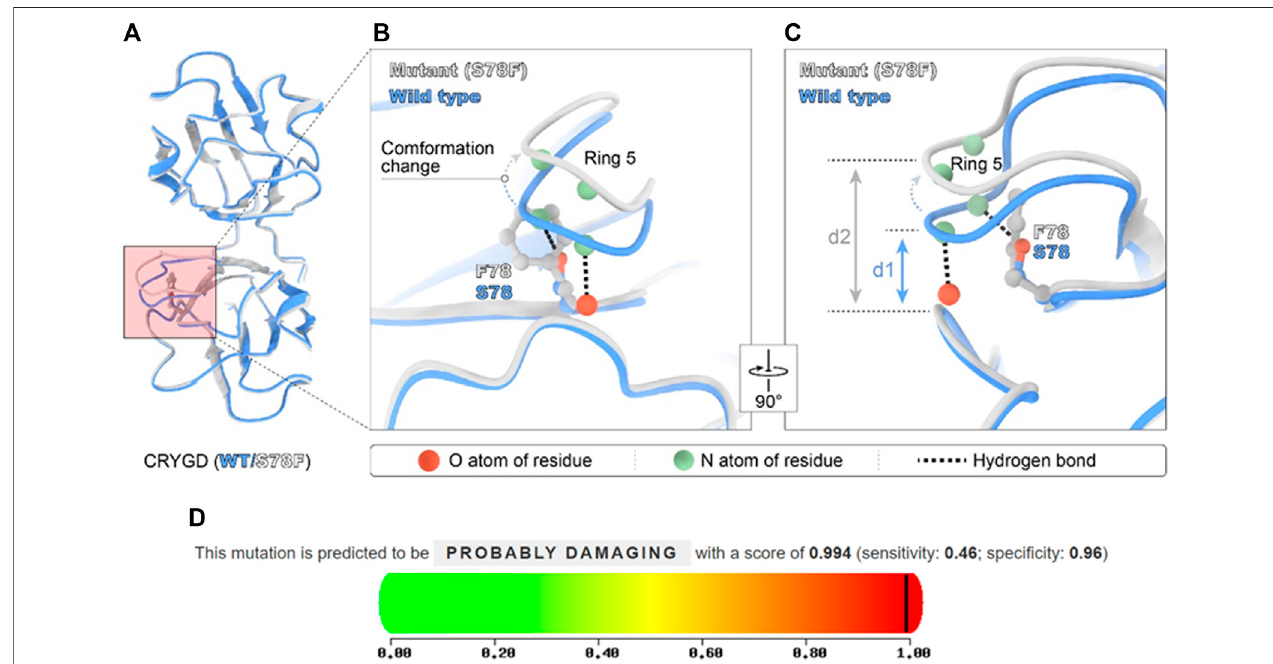
FIGURE 3 | Modeled structure of the CRYGD protein was painted by Chimera X software and the prediction score in PolyPhen-2. Blue indicated CRYGD protein structure in wild type, and the white represent mutated CRYGD protein structure. The mutation described in this study leads to the replacement of serine by phenylalanine at codon 78 (p.S78F), and (A) overall structure of CRYGD. (B) demonstrates this mutation caused obvious conformation change. The phenylalanine located in the corner of the modeled structure made the fi fth ring obvious shifted and longer distance between the two rings. The longer distance broke hydrogen bond between the atoms. (C) shows the conformation change by rotating (B) 90 ° , and clearly reveals a longer distance (d1 represents the distance between ring 5 and ring 2 in wild type, and d2 represents the distance between the two rings in the mutated protein) after mutation. (D) shows this mutation was predicted as probably damaging in PolyPhen-2 software with a score of